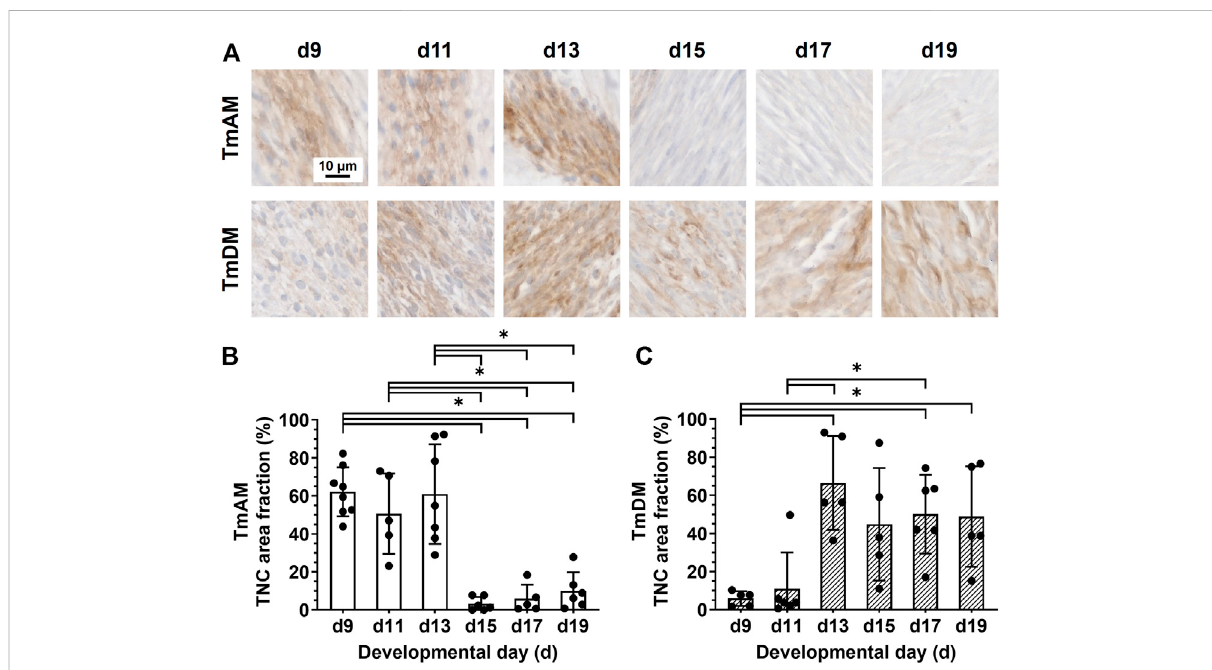
FIGURE 7 TNC showed different temporal patterns in jaw-closing TmAM and jaw-opening TmDM. (A) Representative bright fi eld images of TNC IHC of TmAM and TmDM. (B) In TmAM, percentage area fraction positive for TNC decreased signi fi cantly after d13. (C) In TmDM, percentage area fraction positive for TNC increased signi fi cantly until d13 and then plateaued.